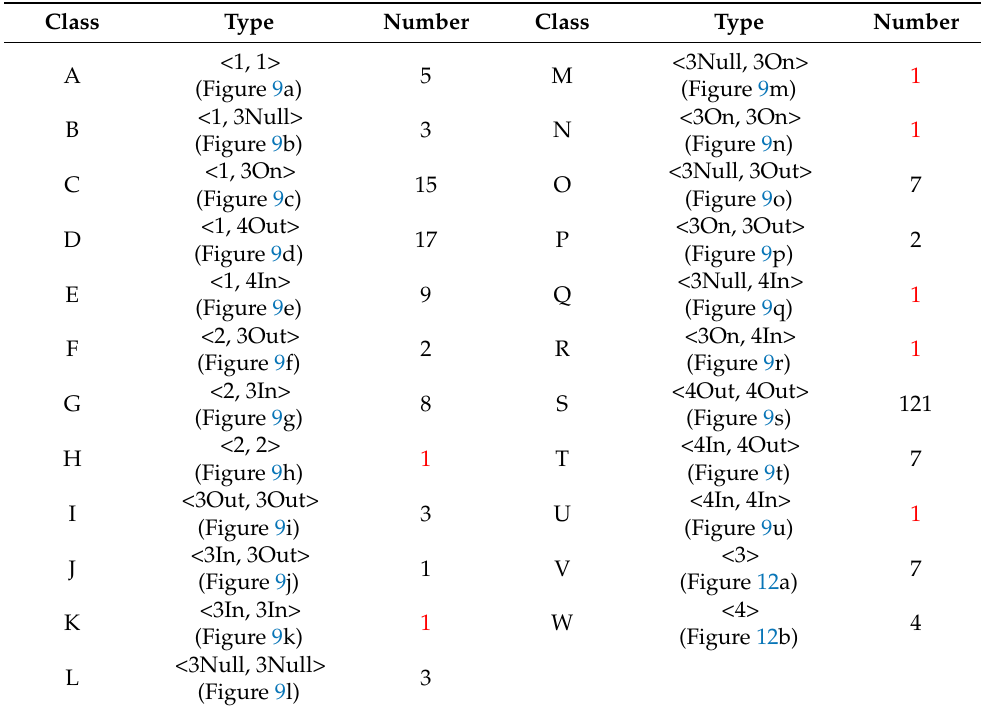
Table 1. Detection results of the intersection components types between traffic lines and water